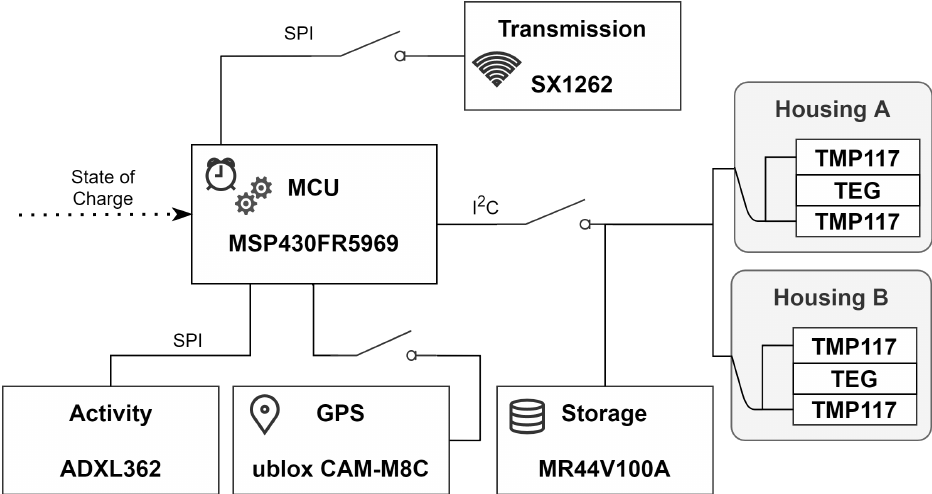
Figure 6. Part of the electrical system responsible for the data acquisition. The MCU controls via digital protocols all periphery and may completely cut each component from the power supply with an additional